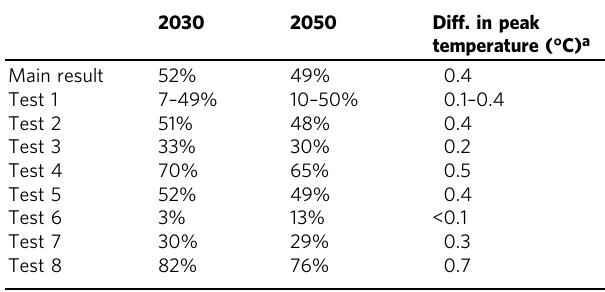
Table 3 Additional sensitivity analyses